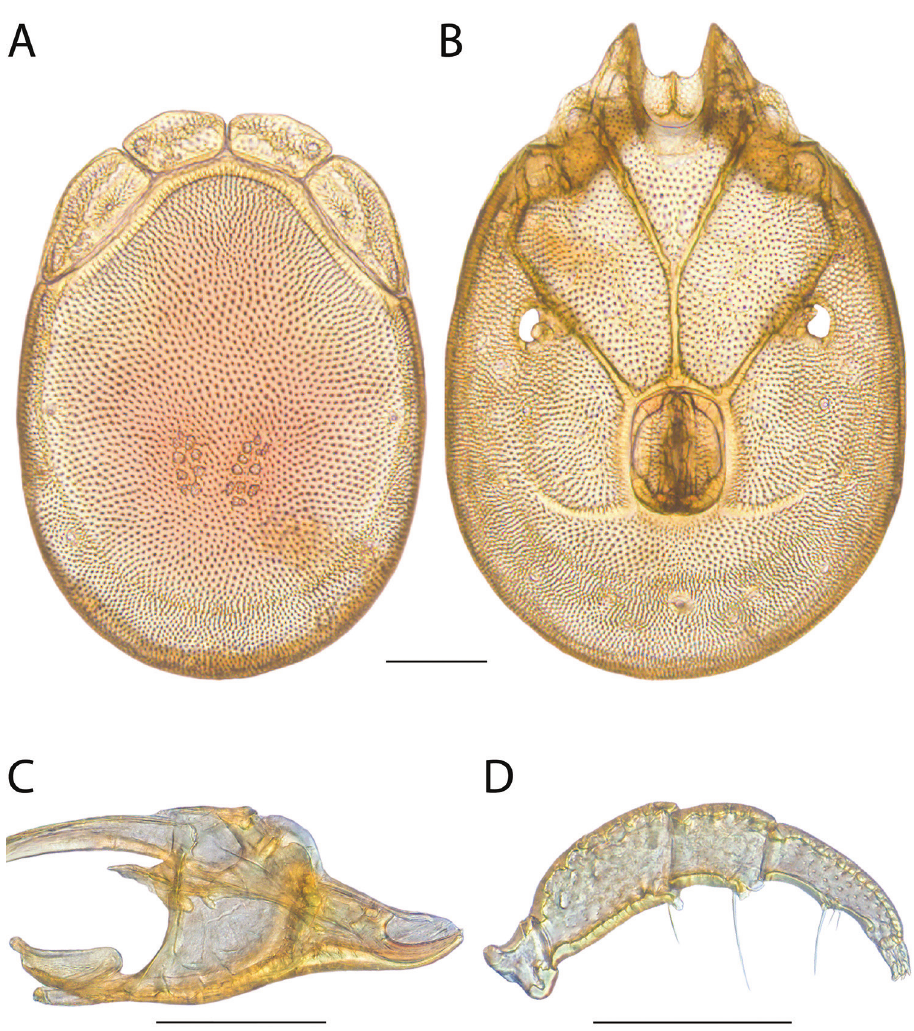
Figure 186. Torrenticola pearsoni sp. n. male: A dorsal plates B venter (legs removed) C subcapitulum D pedipalp (setae not accurately depicted). Scale = 100